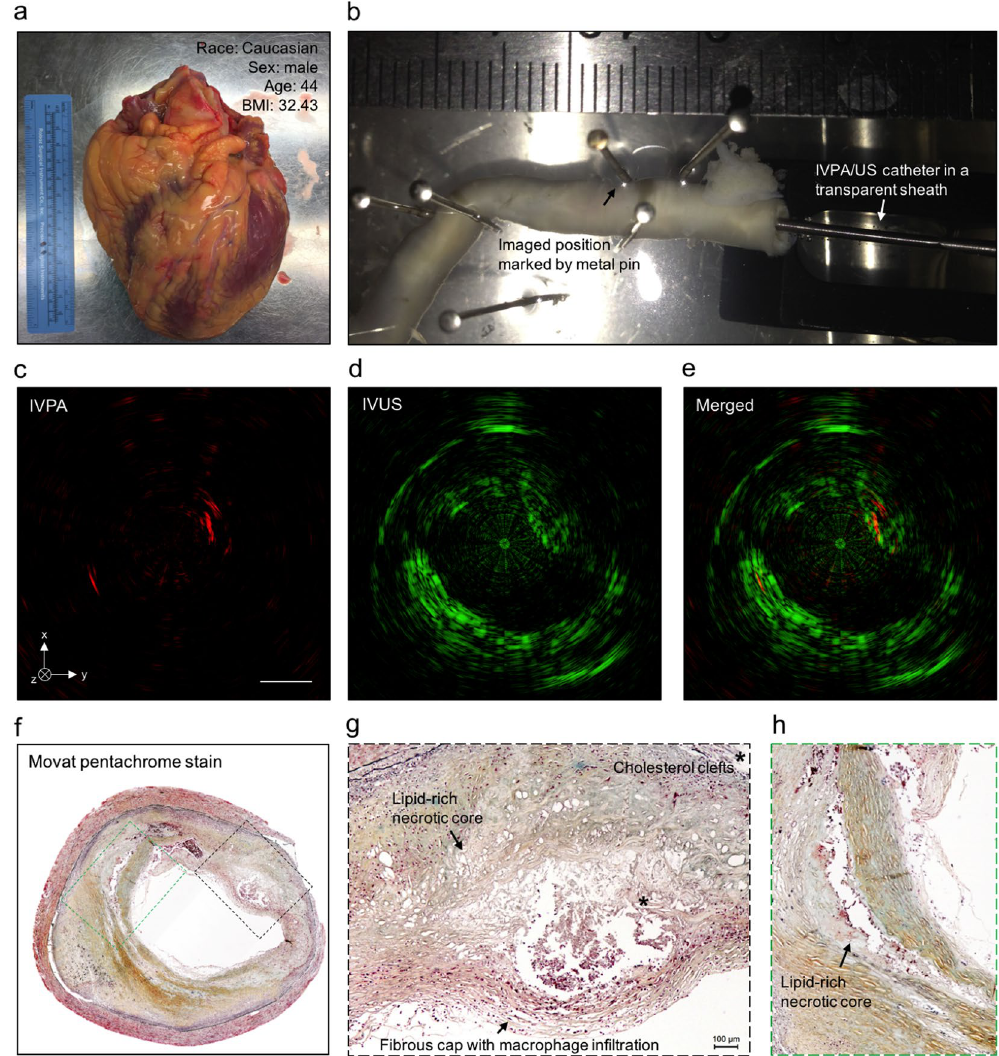
Figure 7. IVPA-US imaging of human coronary atherosclerosis at 16 fps with comparison to histopathology. ( a ) Picture of collected human heart. ( b ) Scenario picture of ex vivo IVPA-US imaging of dissected human coronary artery. The region of interest was marked by metal pin. The catheter and sheath were inserted into the artery lumen. Cross-sectional ( c ) IVPA, ( d ) IVUS, and ( e ) merged images of human coronary artery at the region of interest. ( f ) Gold-standard histopathology stained with Movat’s pentachrome at the region of interest. ( g , h ) Magnified images of lipid deposition sites corresponding to the dashed boxes in ( f ). * Indicates the accumulation of cholesterol